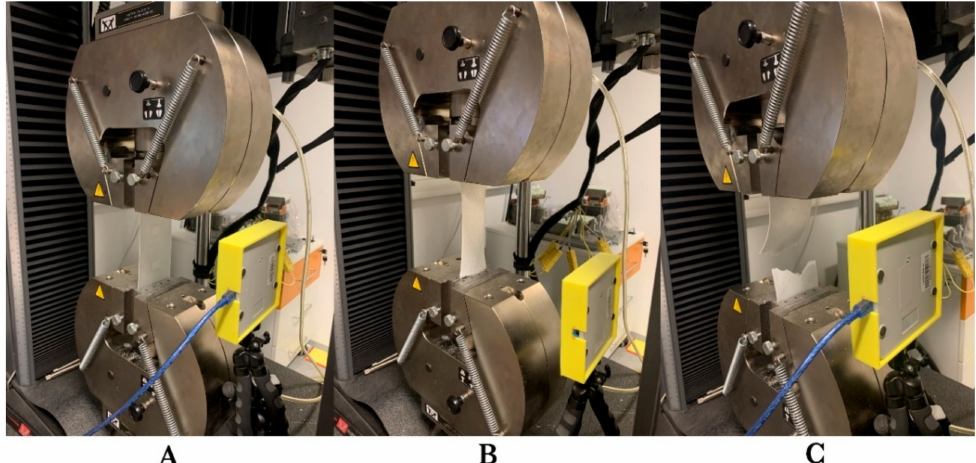
Figure 6. Process of tensile tests of individual laminated samples with passive RFID tags monitored by RFID antenna (Yellow Box), default placement position of the sample clamped in pneumatic flat grips ( A ), course of sample deformation ( B ), and final state after the sample destruction ( C ).